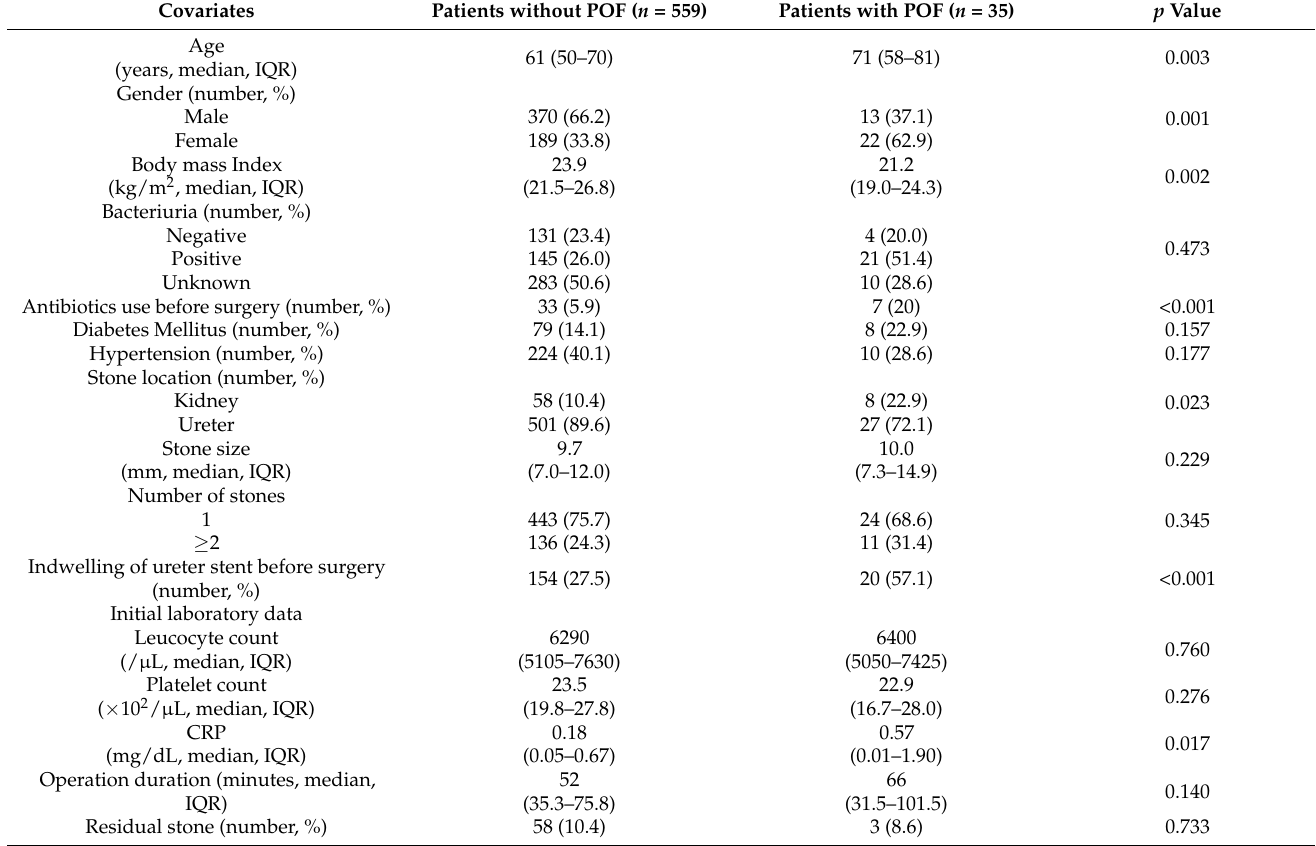
Table 1. Comparison of perioperative covariates and outcomes in patients who had postoperative fever after ureteroscopic lithotripsy or not. Covariates Patients without POF ( n = 559) Patients with POF ( n = 35) p Value Age 61 (50–70) 71 (years, median, IQR)